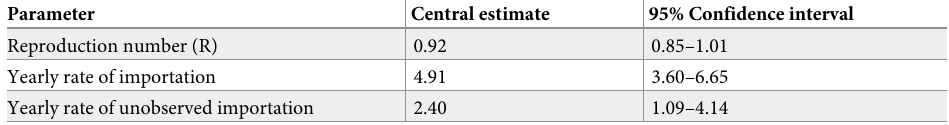
Table 1. Estimates of the reproduction number ( R ) and rate of importation of rabies into the canine population (total and unobserved). The rate of importation was defined as the estimated number of outbreaks per unit of time over the whole study period. The rate of unobserved importation was defined as the estimated number of unobserved outbreaks per unit of time over the whole study period. A reporting rate of 20% was assumed, and pruning cutoff dis- tances corresponding to the 95% quantiles of the input distance distributions were used (see S1 Text for sensitivity analyses on these